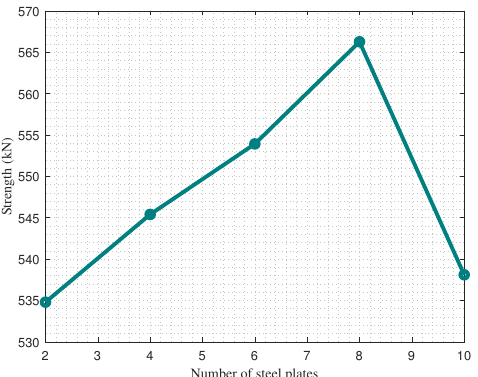
Figure 10. Shear wall strength S for different numbers of steel plates, n .